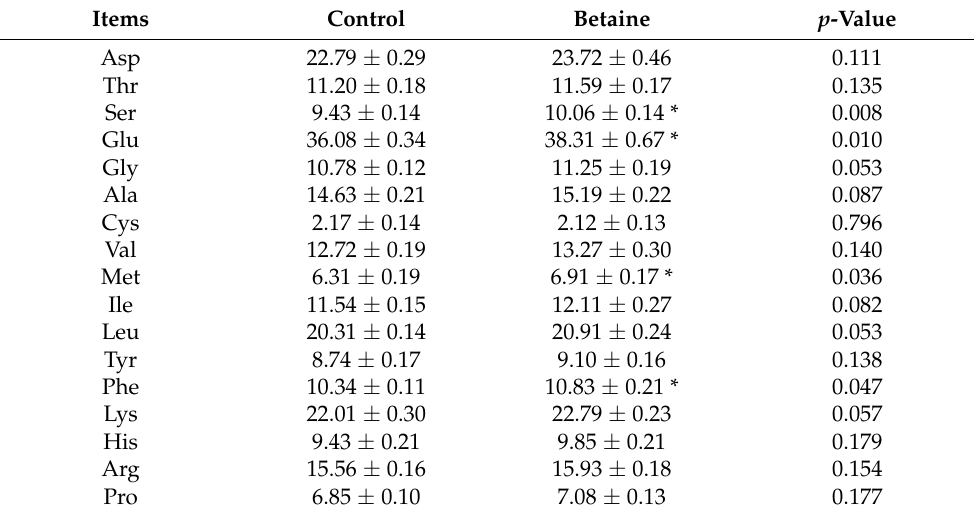
* Mean values within a row with an asterisk differ significantly at p < 0.05.